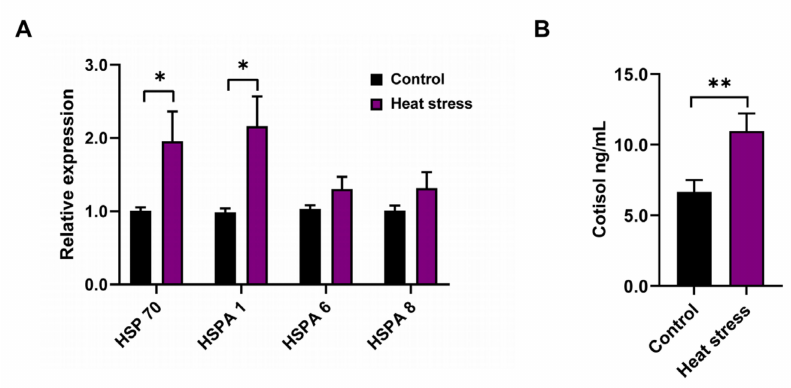
Figure 2. The indicators to evaluate the occurrence of heat stress in goats. ( A ) The expression levels of Hsp 70 family member genes in blood and rumen fluids ( n = 6). ( B ) The serum cortisol concentrations in goats in the control and heat stress periods ( n = 12). Data are expressed as the means ± SEM. * p < 0.05 and ** p < 0.01, indicating significant differences between the control and heat stress